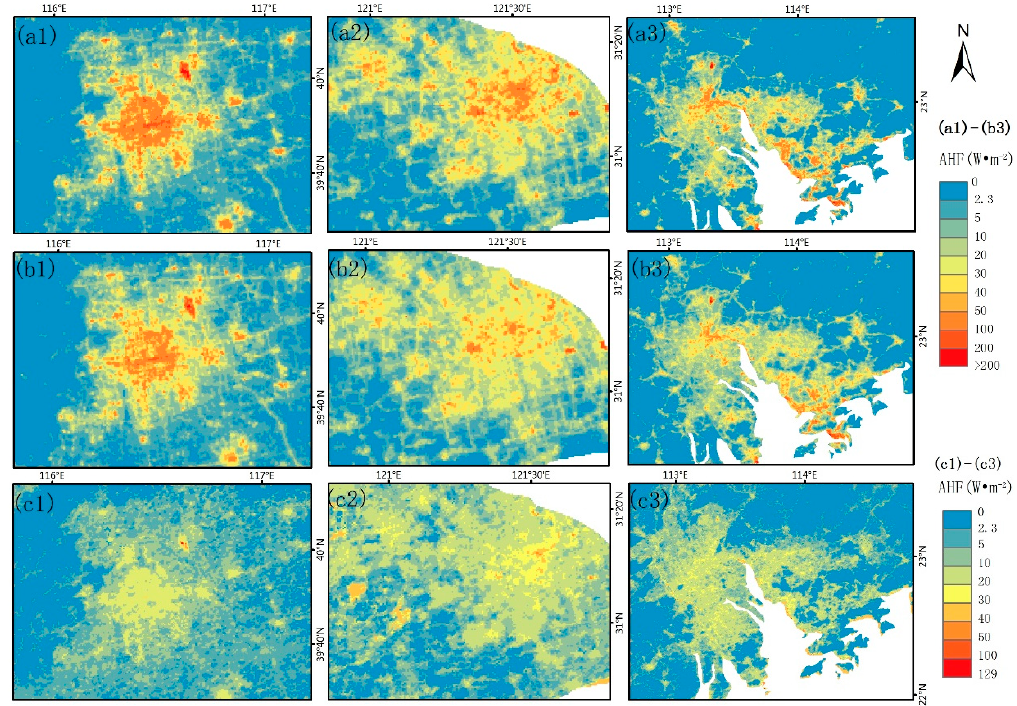
Figure 8. The AHF estimation results of the three indexes. ( a1 – a3 ) VANUI; ( b1 – b3 ) normalized nighttime light data (NTL nor ); ( c1 – c3 ) HSI.